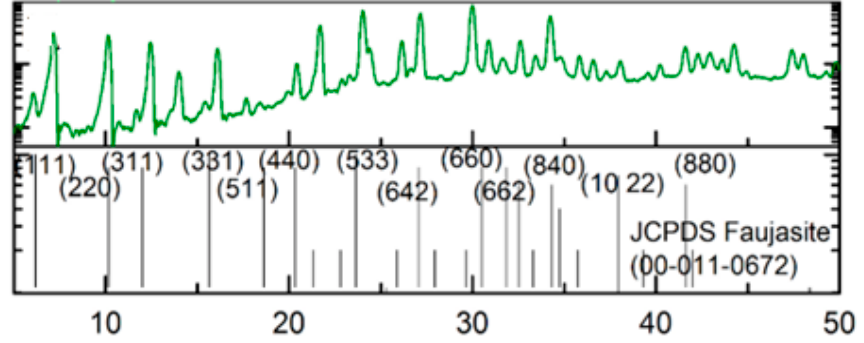
Figure 3. Diffractogram pattern of zeolite X.